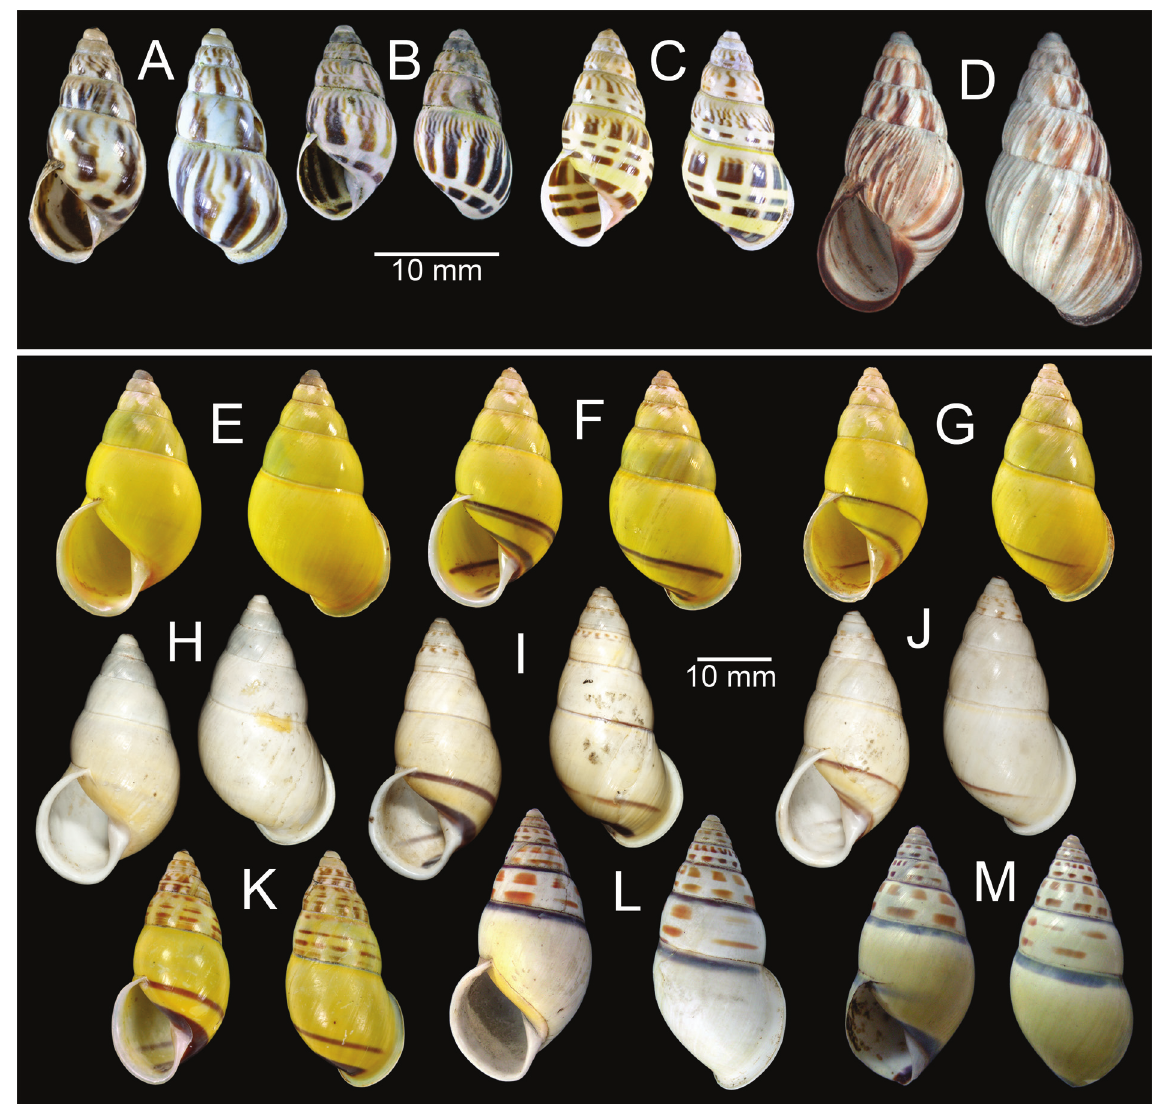
Fig. 10. Shells of Amphidromus ( Syndromus ) spp. A−C . Amphidromus areolatus (Pfeiffer, 1861) from Thad Fek, Attapeu, Laos (CUMZ 7022). D . Amphidromus begini (Morlet, 1886), syntype from Strung- Trang, Cambodia (MNHN-IM-2000-1832). E-G . Amphidromus flavus (Pfeiffer, 1861) from Tam Pou Kham, Vientiane, Laos (CUMZ 7029). H . Amphidromus flavus var. “ indistinctus ” Pilsbry, 1900, holotype (ANSP 31486). I–K . Amphidromus flavus var. “ tryoni ” Pilsbry, 1900. I . Lectotype (ANSP 31488). J . Paralectotype (ANSP 252745). K . Specimen from Ban Na Deauy, Luang Phrabang, Laos